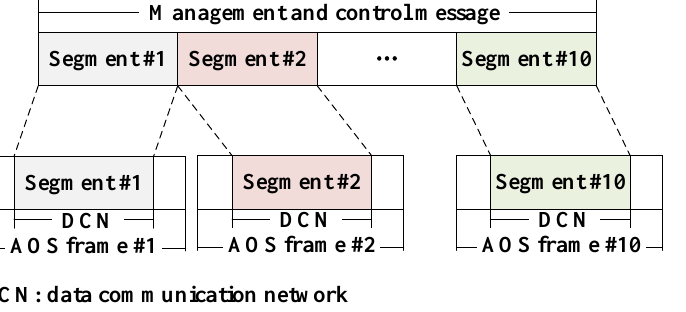
Figure 5. The transmission of a fixed bit length managing and controlling message in the data communication network field of the AOS frame.